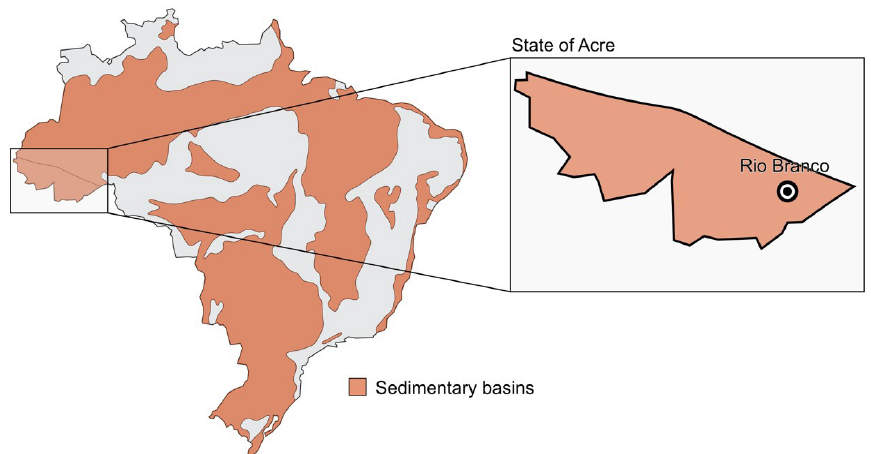
Figure 1. Map of Brazil identifying the sedimentary basins and the State of